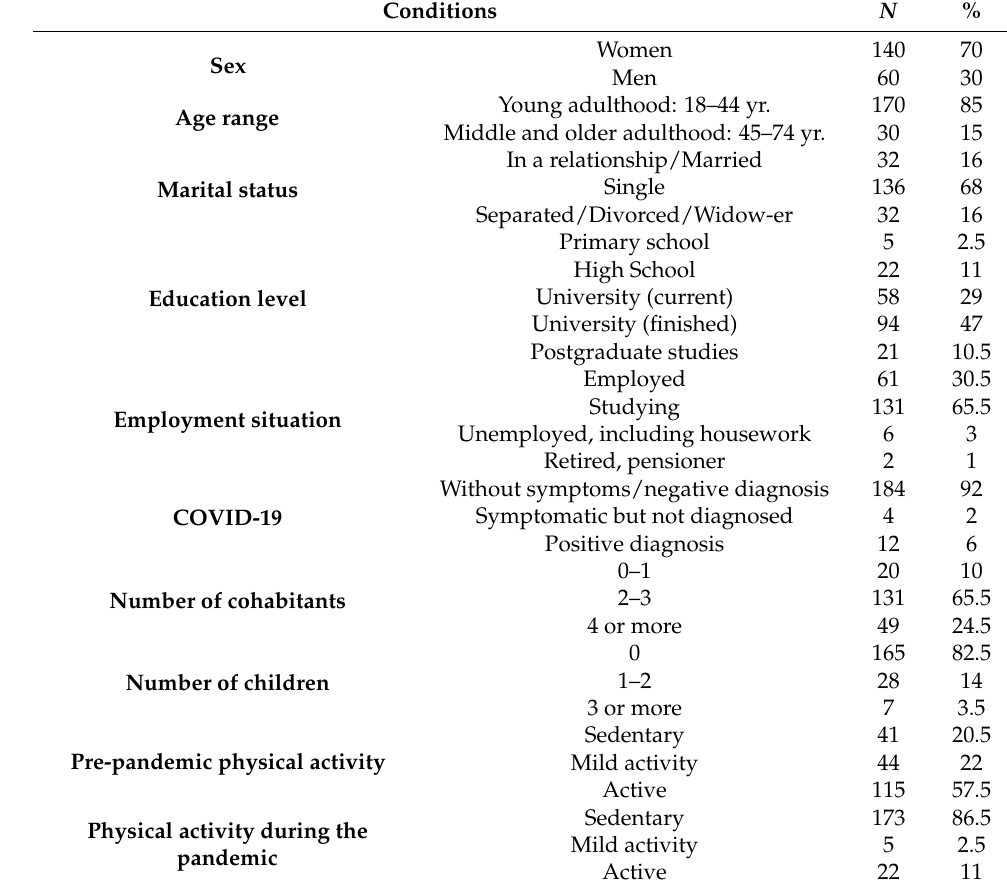
Table 1. Sociodemographic data from the